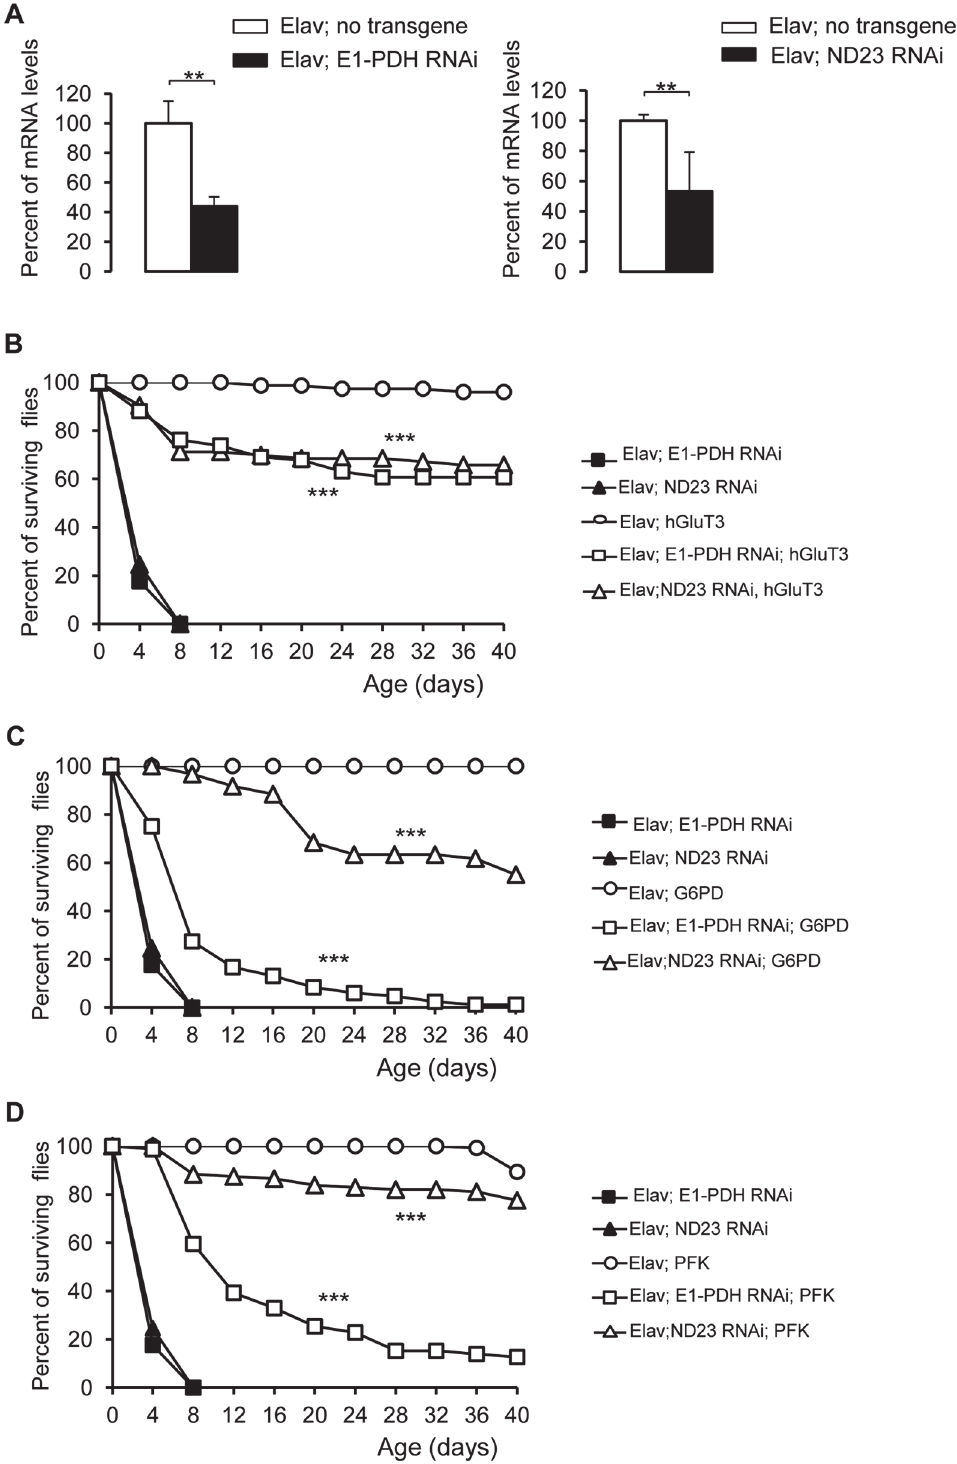
Fig 6. Survivals of flies overexpressing hGluT3 or G6PD or PFK with mitochondrial dysfunctions in neurons. ( A ): RT-qPCR assays for E1-PDH and ND23 transcripts showing reduced levels of each transcript in flies expressing the RNAi under the Elav -Gal4 driver. Transcripts levels (filled bars) were expressed in percent relative to controls (no transgene; open bars). They represent the means + SEM of at least 3 separate experiments prepared from heads at the first day of adult age. The one-tailed Mann-Whitney test indicates a difference in mRNA levels between the RNAi-induced and control genotypes